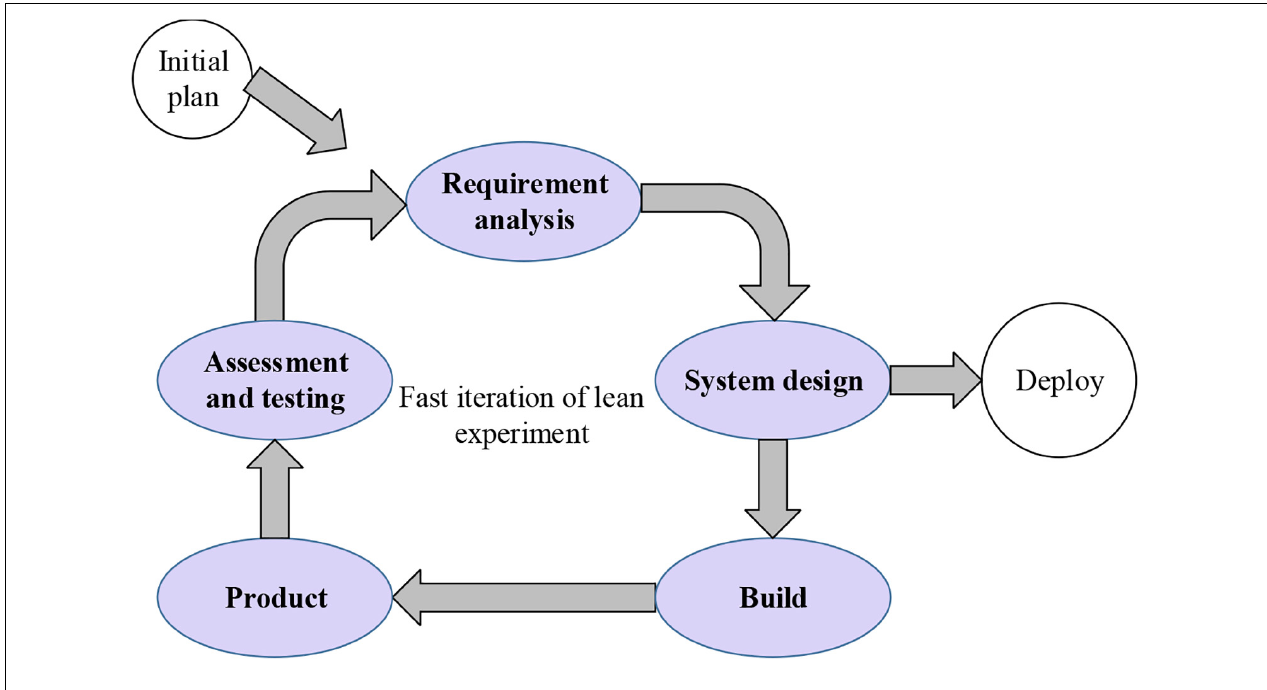
FIGURE 1 | The cyclical process of lean entrepreneurship theory.